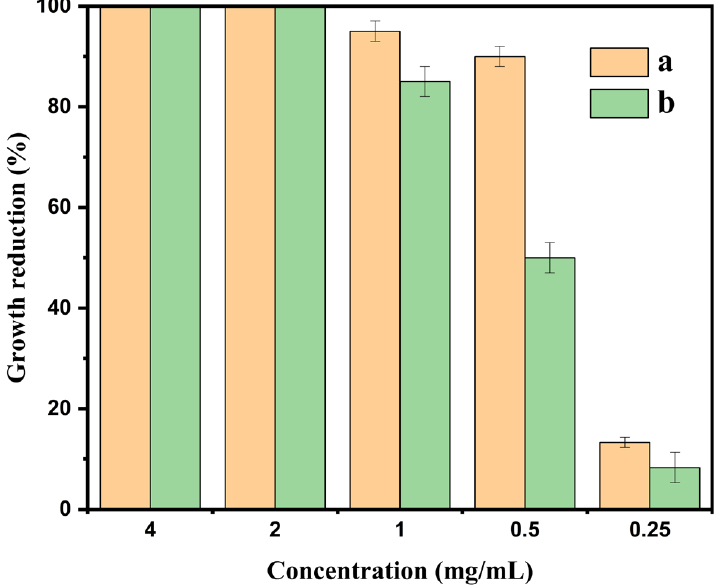
Figure 10. The growth curve of E. coli treated with (a) M-NH 2 -CIT@CIT and (b) M-CIT.